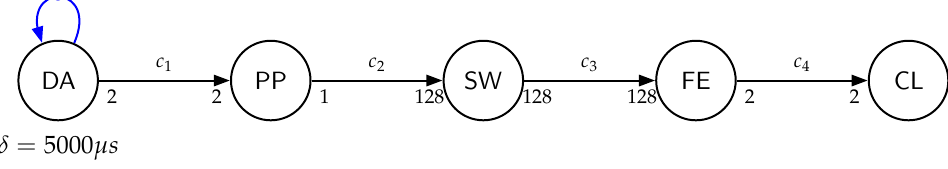
Figure 3. SDF graph of an example